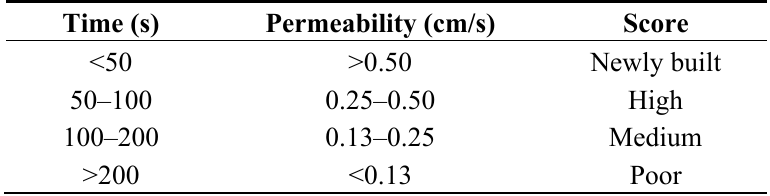
Table 1. Criteria for defining the permeability of a porous mixture surface when using the LCS permeameter.